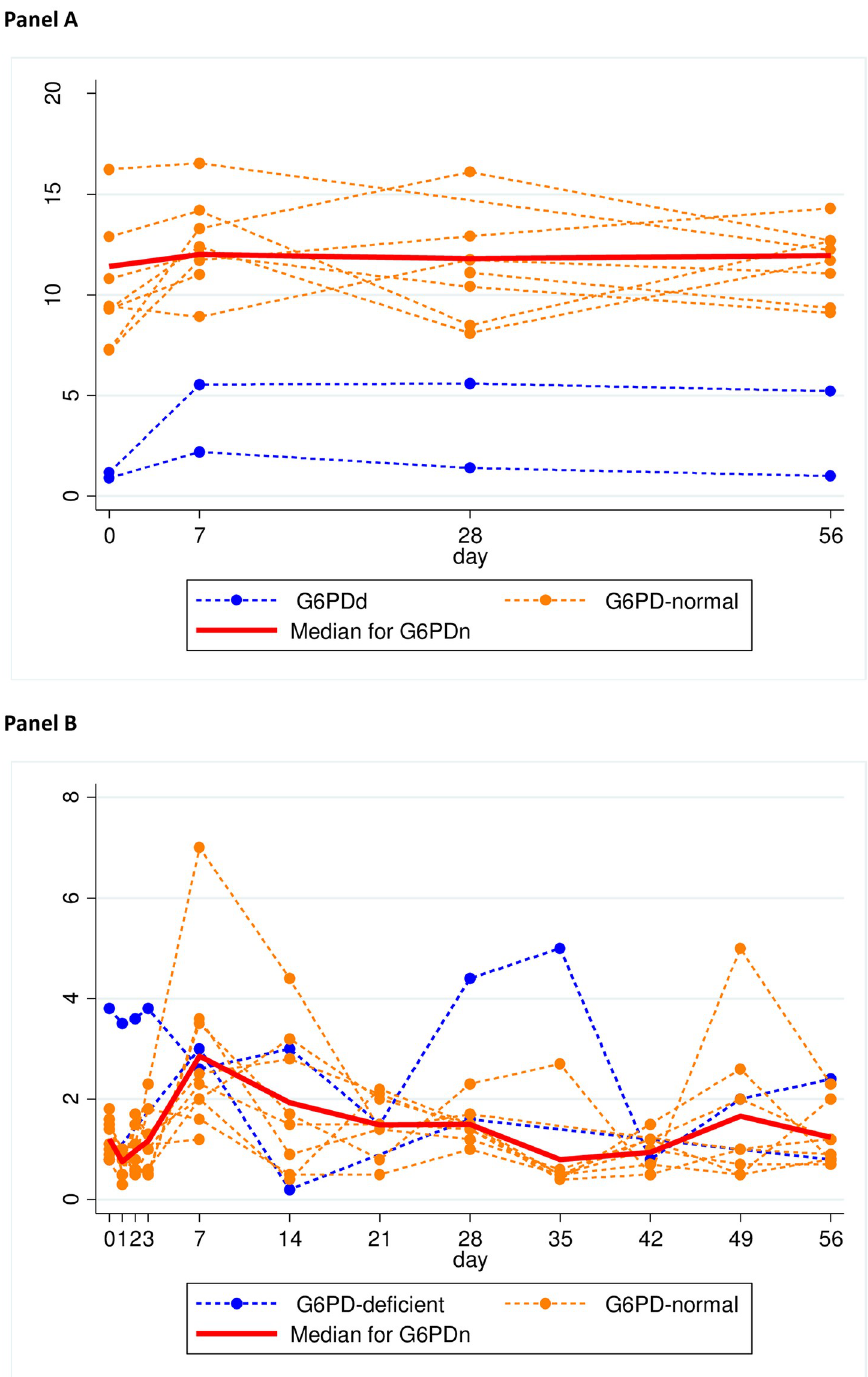
Fig 2. Time course of G6PD activity and reticulocyte counts in female vivax-infected patients given weekly primaquine. Panel A: G6PD activity. Panel B: reticulocyte counts.